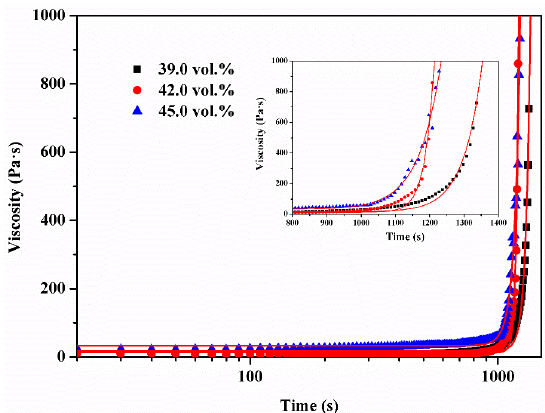
Figure 8. Semilog plots of viscosity as a function of gelation time for KNN suspensions with different solid loadings containing 15.0 wt.% hydantoin epoxy resin at 55 °C.